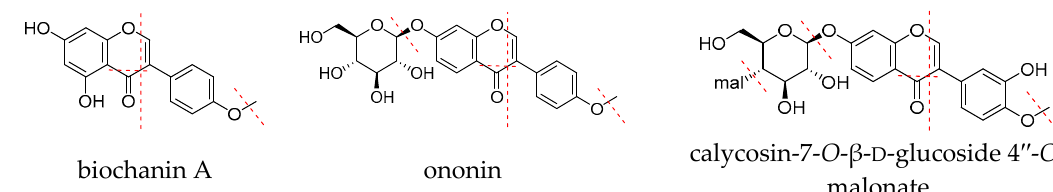
Figure 1. The fragmentation pathways of biochanin A, ononin and calycosin-7- O - β - D -glucoside 4”- O - malonate.